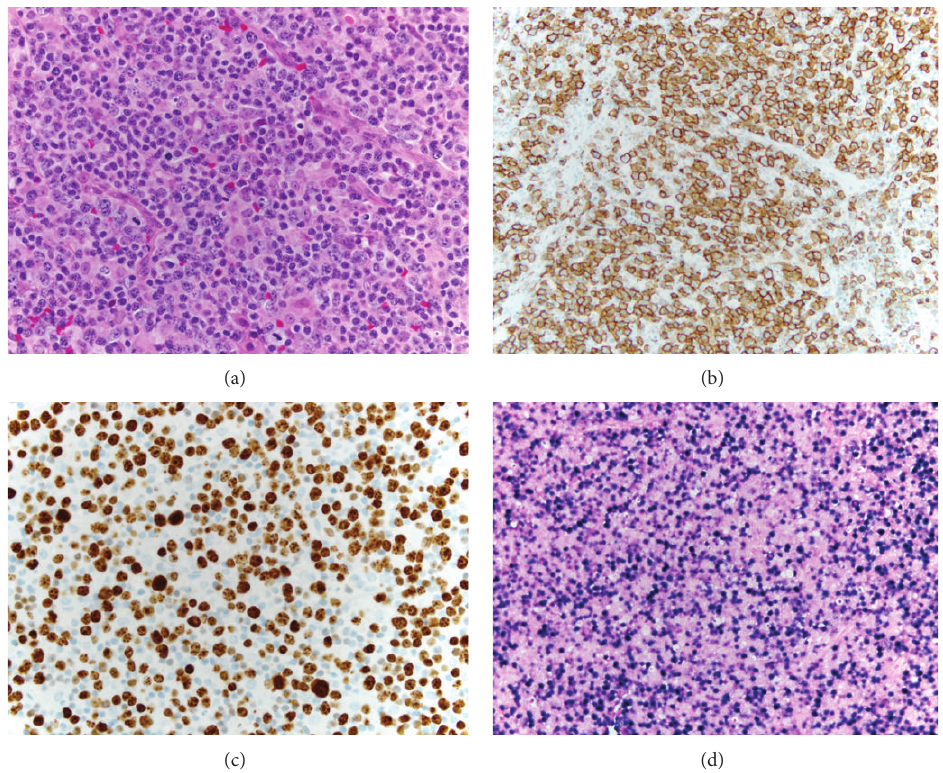
Figure 1: (a) Lymph node with small and large atypical lymphoid cells admixed with histiocytes, immunoblasts, plasma cells and eosinophils; H&E 400x. (b) CD20 immunostain highlighting the small and large atypical B-cells. (c) Ki-67 highlighting the high proliferative rate. (d) EBER-ISH showing diffuse